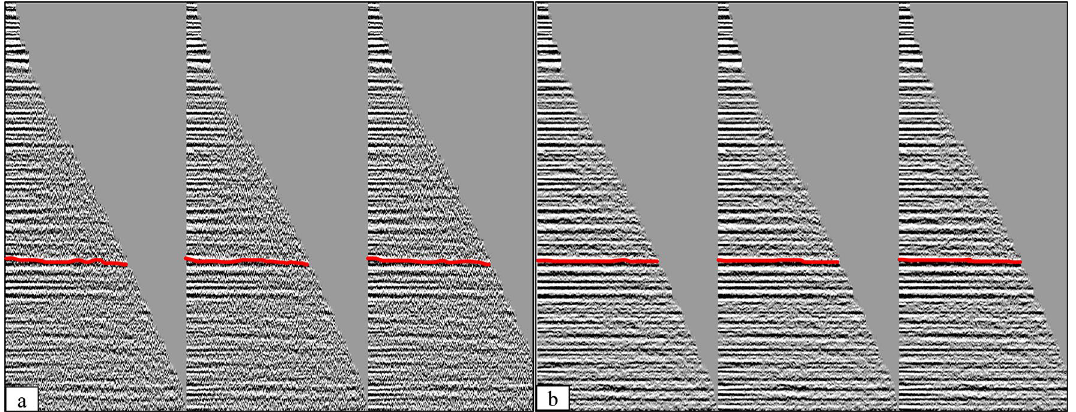
Fig. 5 a Unconditioned gathers and b conditioned gathers. Reservoir target zone is drawn with red marker (horizon). Reservoir zone shows an area of significant improvement after data